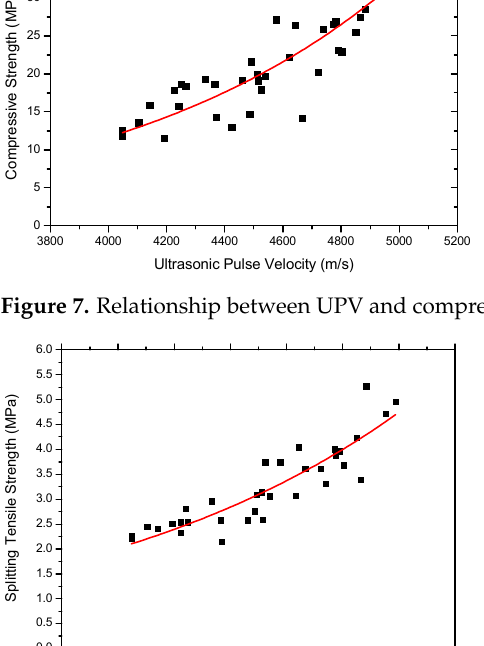
Figure 7. Relationship between UPV and compressive strength.